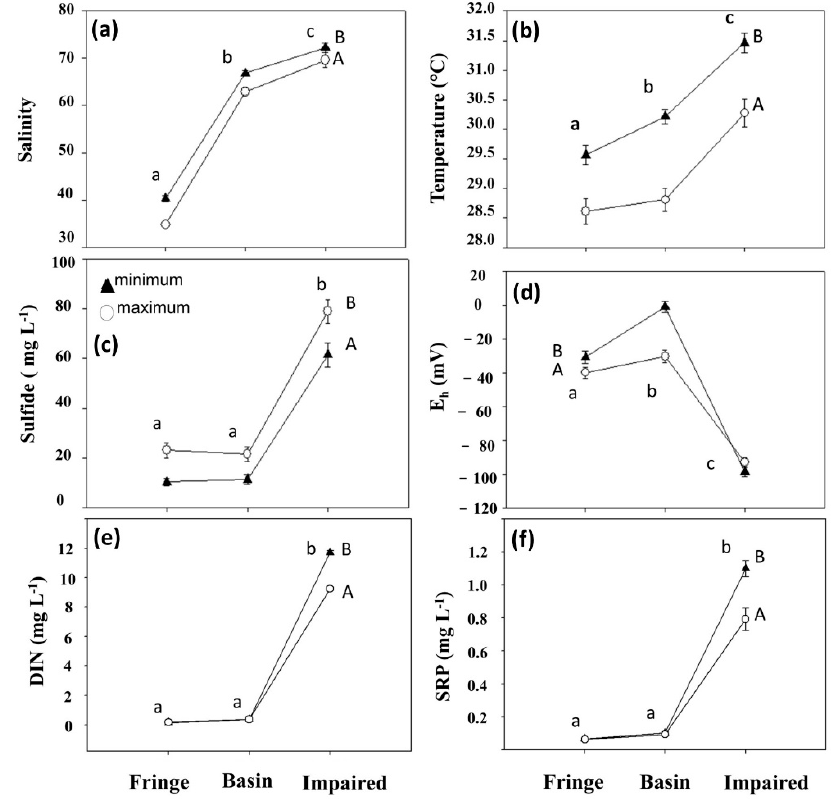
Figure 5. Temporal variability of ( a ) salinity, ( b ) temperature, ( c ) sulfides, ( d ) Eh, ( e ) dissolved inorganic nitrogen (DIN), and ( f ) soluble reactive phosphorus (SRP) at the minimum and maximum flooding seasons for the three study sites. The different lower-case letters represent the significant differences between sites. The different upper-case letters indicate significant seasonal differences (minimum and maximum flooding).